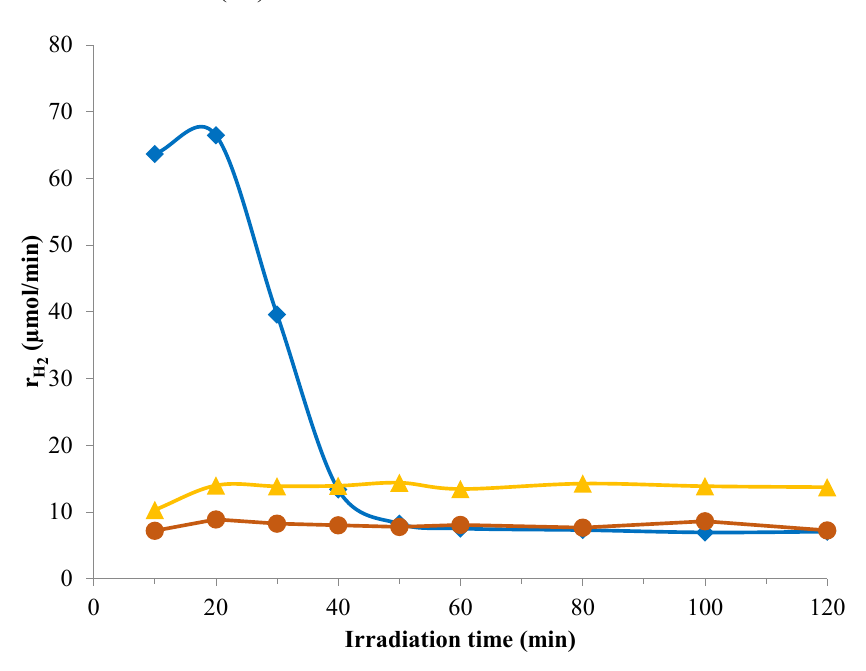
Figure 8. Photocatalytic H 2 evolution in the presence of oxalic acid using Pt-TiO 2 (  ) and Au-TiO 2 with similar average noble metal particle size (  ) or synthetized by the same chemical reduction method